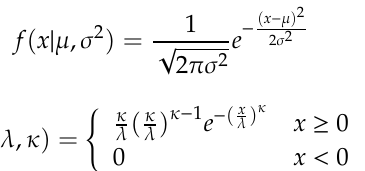
Figure 4. PDF of travel distance.